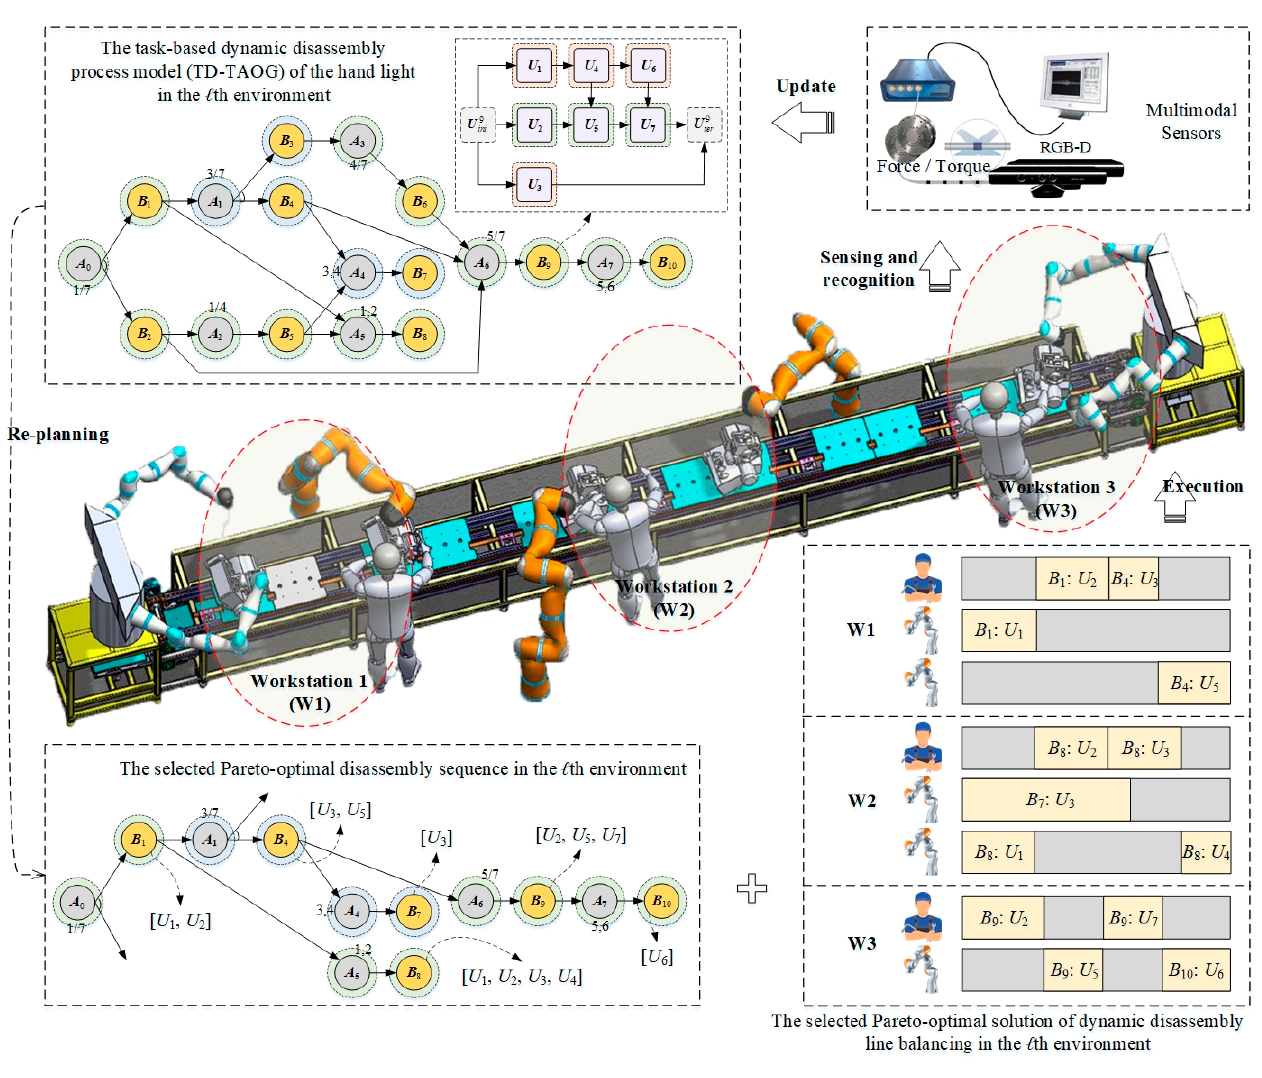
Figure 3. Example of a D-HRDLB problem in the ℓ th environment.